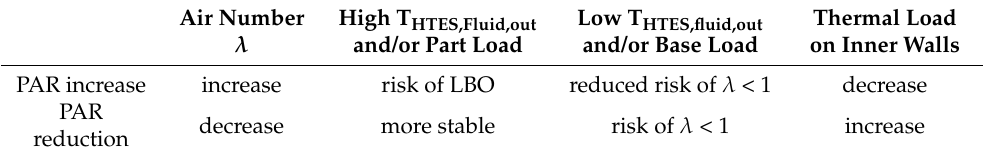
Table 6. General trends for PAR change on stability, air number λ , and thermal load on material.